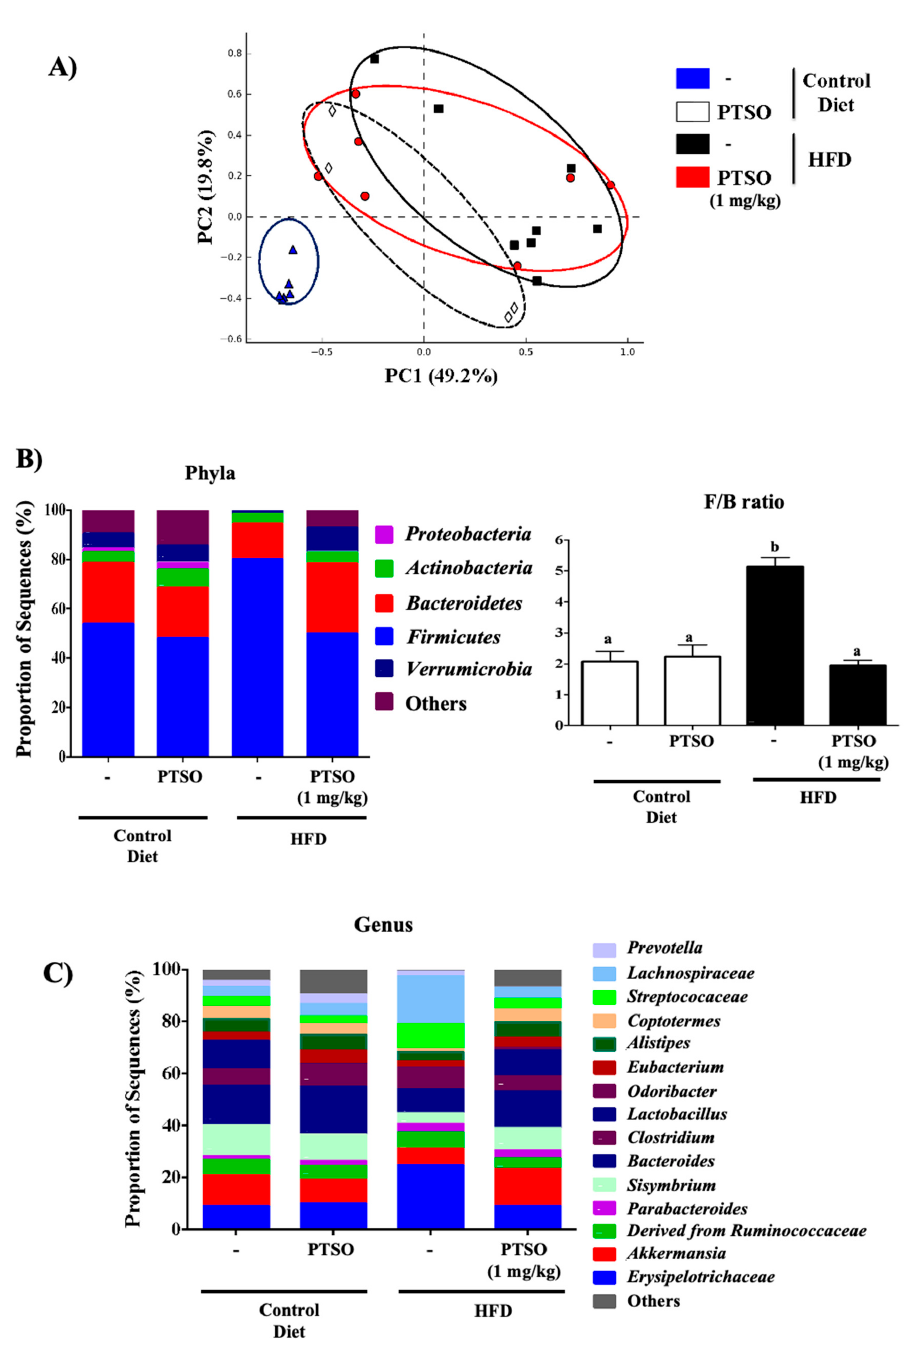
Figure 7. Impact of propyl propane thiosulfonate (PTSO) on fecal microbiota composition: ( A ) principal component analysis plot; ( B , C ) bacterial community (phyla, genus) and the F/B ratio. Groups with different letters statistically differed ( p < 0.05).